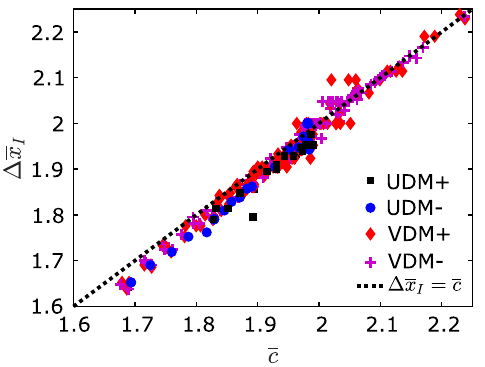
FIG. 17. Dimensionless width Δ ¯ x I shown to be equal to ¯ c for all models across the range of f and K investigated in Fig. 3, max corresponding to an expansion that travels the width of the infected region every lysis time. We attribute the small discrep- ancy observed at lower values to the limited convergence of the front profile to its steady state because of trade-offs between precision and computational